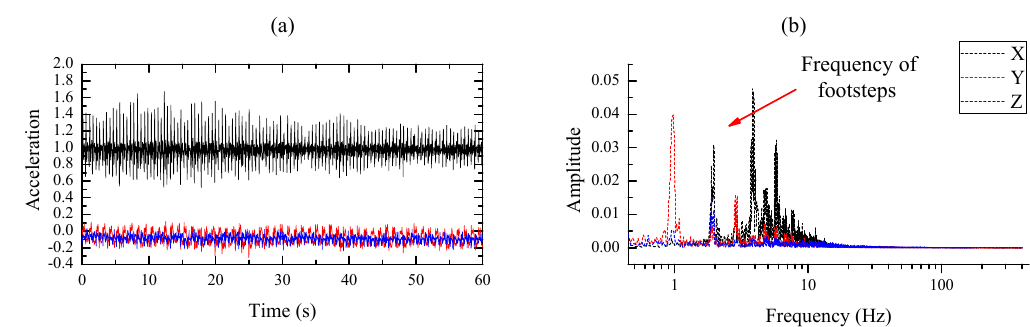
Figure 4. ( a , b ) Time plot and frequency plot of heartbeat signal respectively.